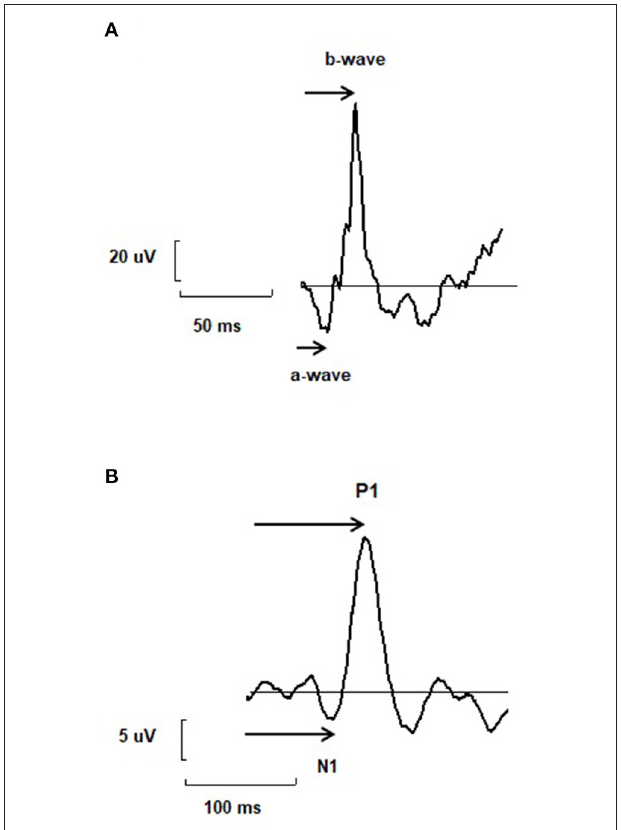
FIGURE 1 | (A) A typical trace of electroretinogram (ERG) with two main components named a- and b-wave. The arrow represents the way the implicit time or peak time of each wave is measured. (B) A typical trace of electroencephalogram (EEG) recorded using visual stimulations and called visual evoked potential (VEP), with two main components N1 and P1. The arrow represents the way the implicit time or peak time of each wave is measured. The retino-cortical time is the difference between the implicit time of N1 and